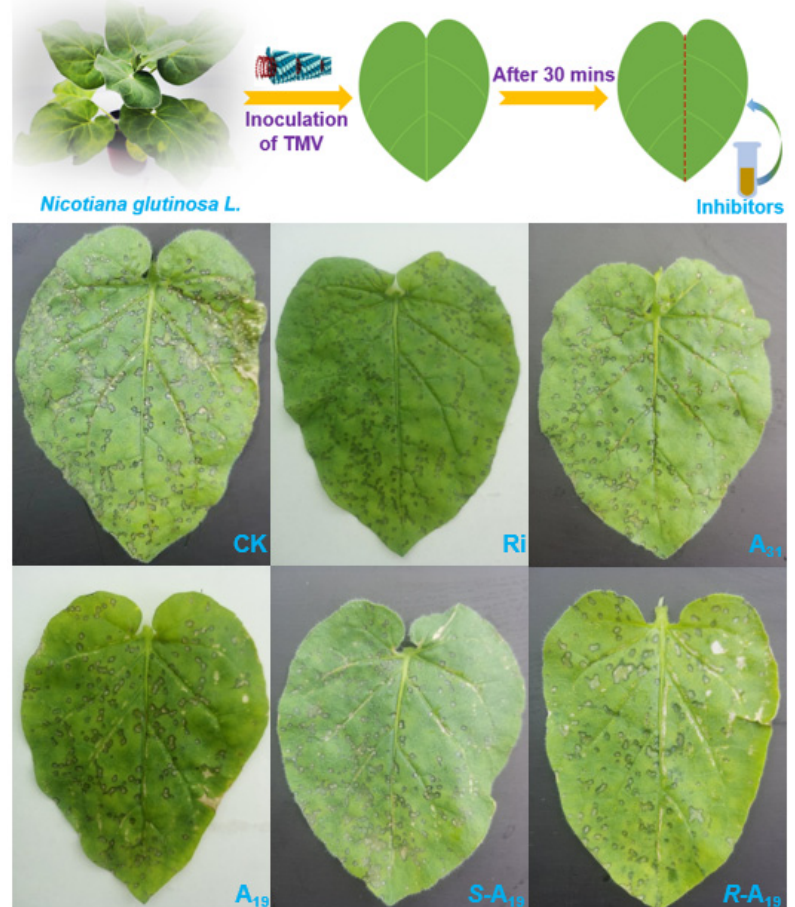
Figure 6. A schematic diagram of the classical half-leaf inoculation approach, and representative pictures of target compounds and the in vivo anti-TMV curative effect of ribavirin (Ri) at 500 µ g/mL. The leaves were inoculated with 1% DMSO as a blank control (CK).